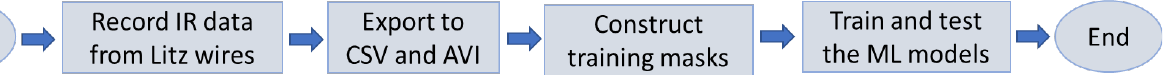
Figure 2. A picture of the setup used for experiments using the IR camera.